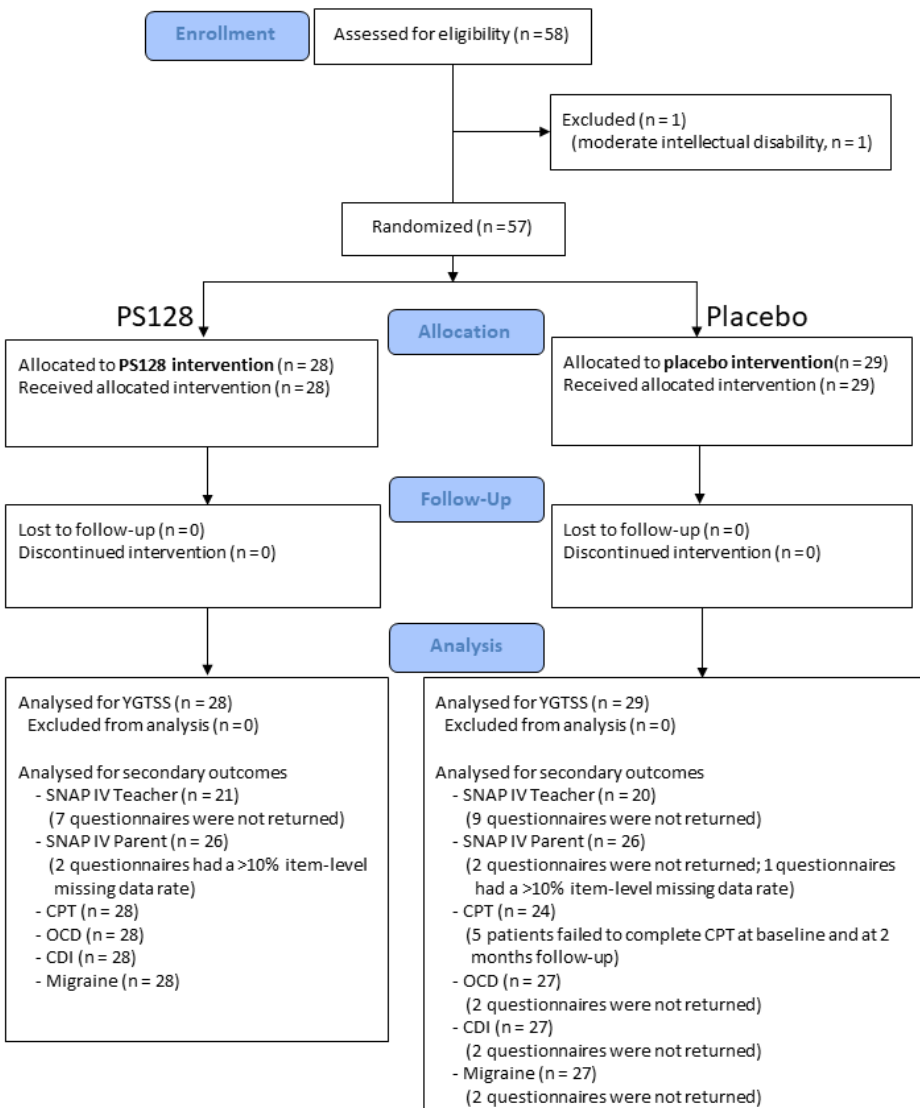
Figure 1. CONSORT diagram of the randomization and follow-up of the study participants.